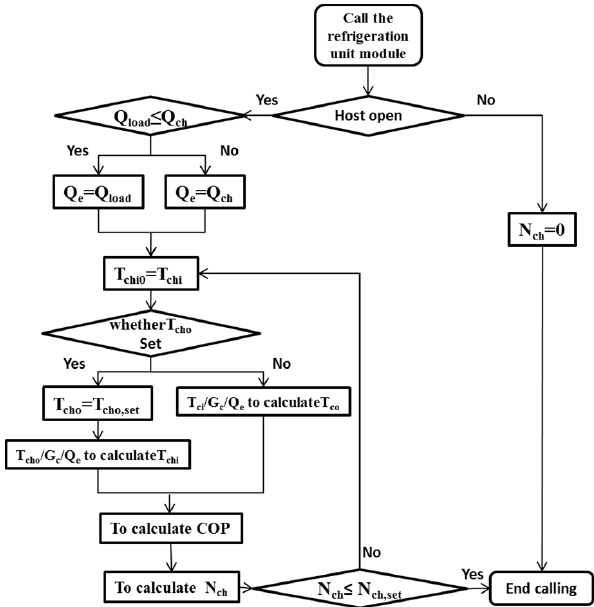
Figure 5. Flowchart of a custom chiller module program.